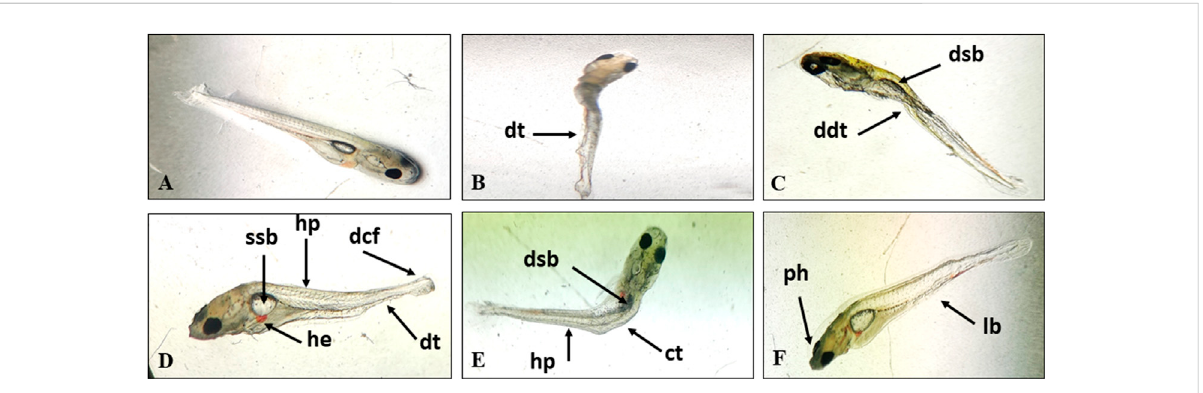
FIGURE 1 Normal larva (A) and TCS induced deformities in the hatchlings of L. rohita , dt, degeneration of tissue; ddt, degenerated digestive tract; dsb, de fl atedswimbladder;ssb,smallswimbladder;hp,hypopigmentation;dcf,deformedcaudal fi n;he,hemorrhage;ct,curvedtrunk;ph,pointedhead; lb, lean body (B – F)